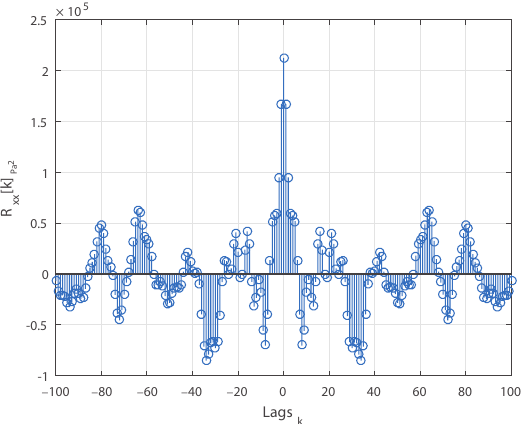
Figure 5. Autocorrelation sequence with lags limited to 100.